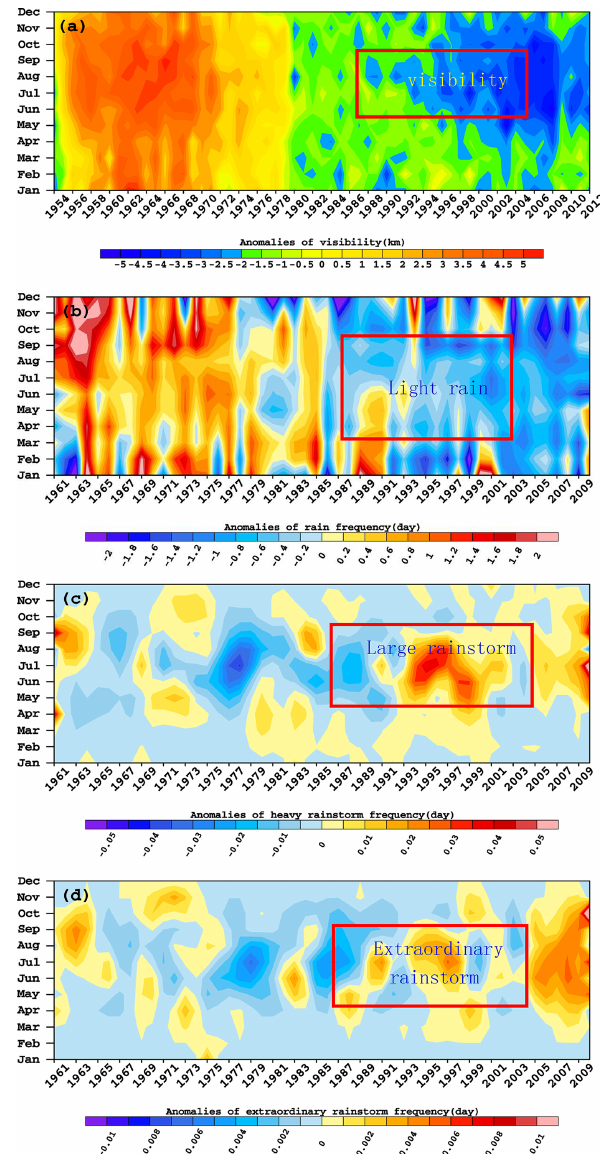
Figure 8. Monthly anomalies of number of days with (a) visibility, (b) light rain, (c) heavy rain and (d) extremely heavy rain from 1961 to 2010 averaged over EC. The red rectangles mark the areas with significant